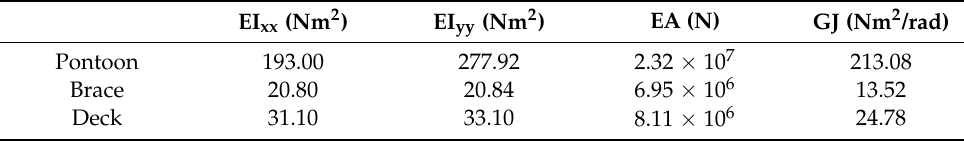
Figure 3. Elastic models of the platform used in the water tank test and the numerical simulation. Table 2. Stiffness properties of the elastic beam in the laboratory-scale model.